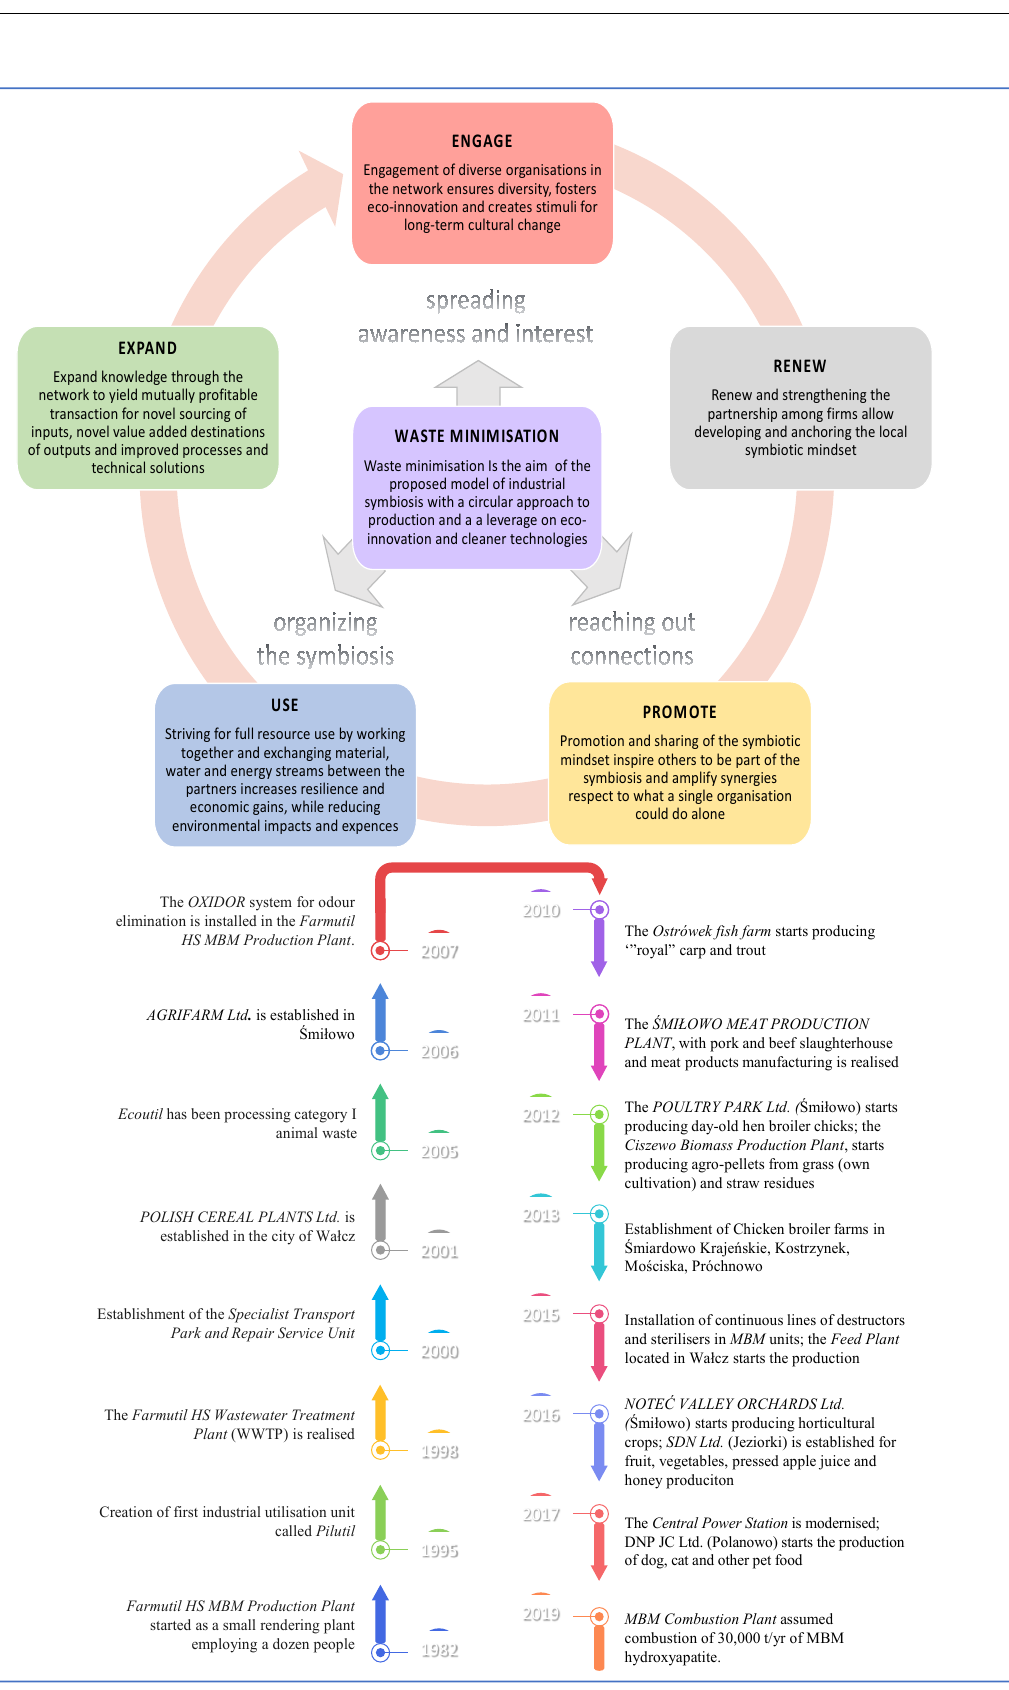
Figure 1. Key actions and main steps for the development of industrial symbiosis in the Ś mi ł owo Eco-Industrial Park (from 1982 to 2021).